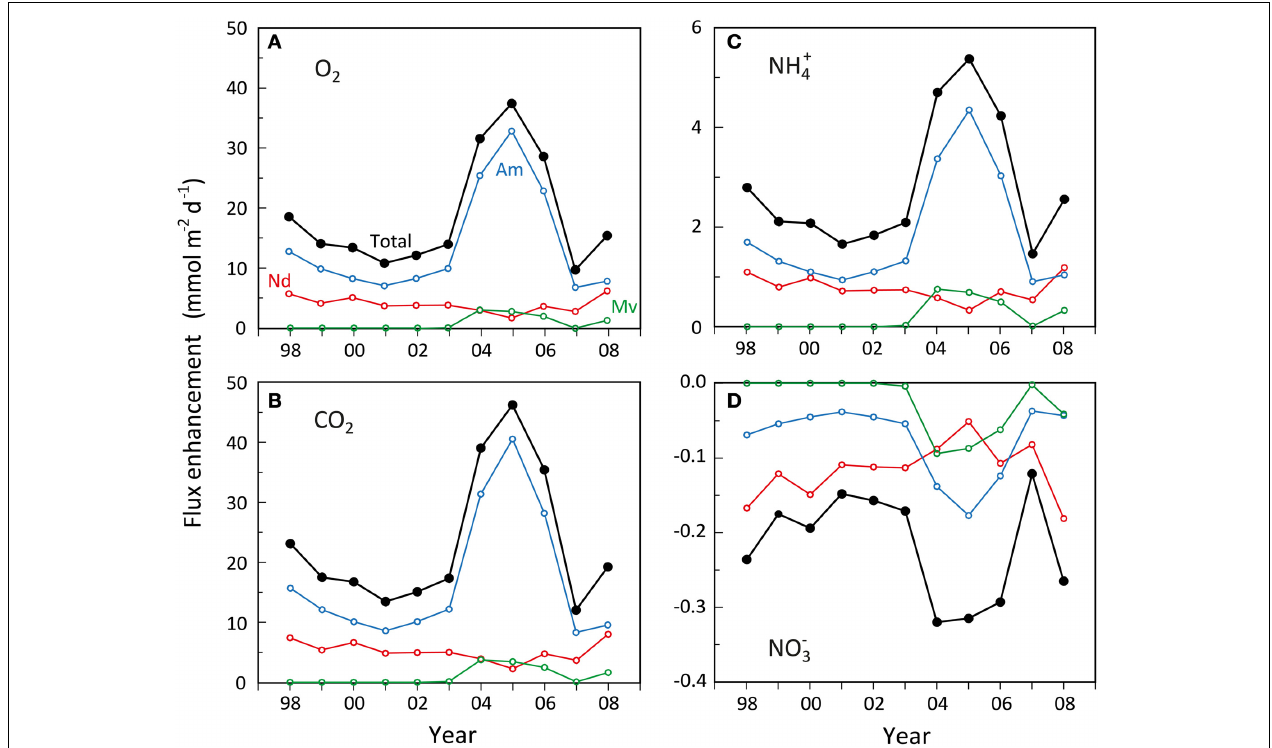
FIGURE 7 | Estimated development in enhancement of (A) benthic O 2 uptake, (B) benthic CO 2 release, (C) benthic NH + 4 release and (D) benthic NO − 3 uptake during summer (15 ◦ C) caused by Nereis diversicolor (Nd), Arenicola marina (Am) and Marenzelleria viridis (Mv) populations in the